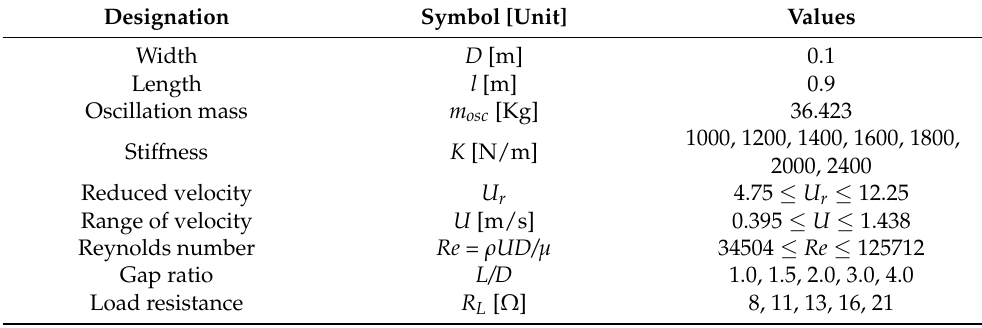
Table 3. Parameters of the physical model.